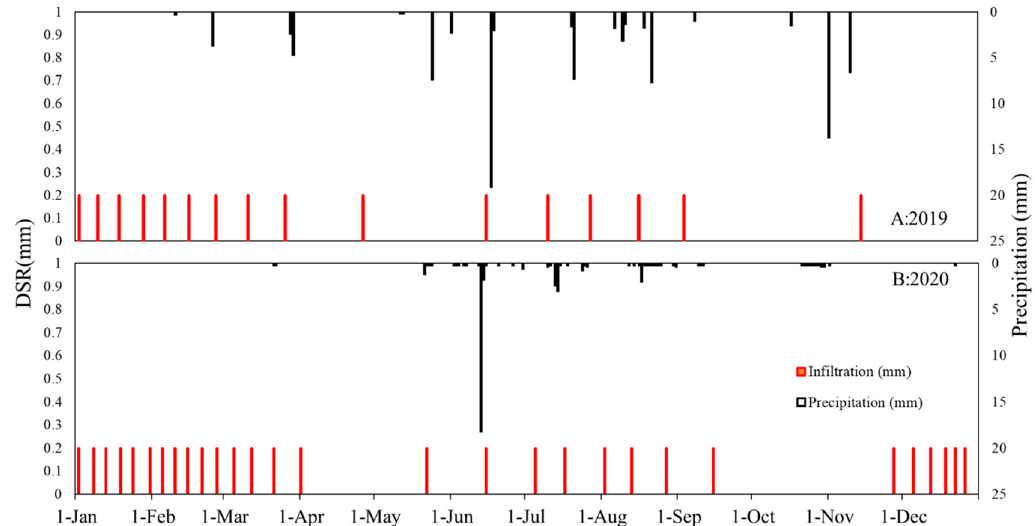
Figure 5. Annual precipitation and DSR variations in 2019 and 2020. Table 1. Monthly cumulative precipitation—DSR amount in every month from 2016 to